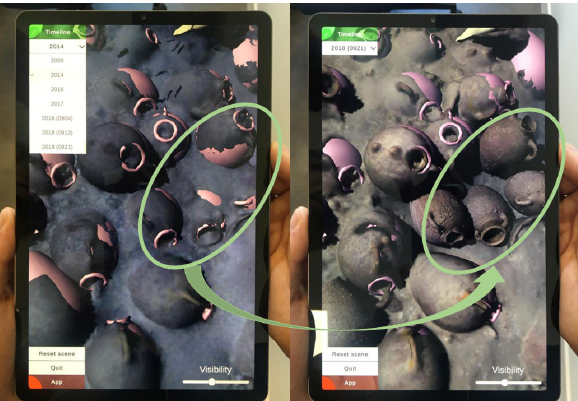
Figure 6. Timeline visualization. Site evolution between 2014 and 2018: Four amphorae were recovered from the wreck before 2018, scanned in laboratory and are now represented fully tex- tured. The other amphorae, still partially covered with sediment are not